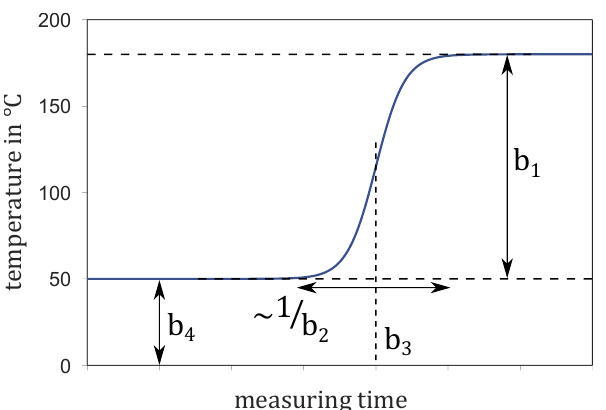
Figure 6. Temperature zones’ profiles of a melting process in February 2020. An example is shown in Figure 7.